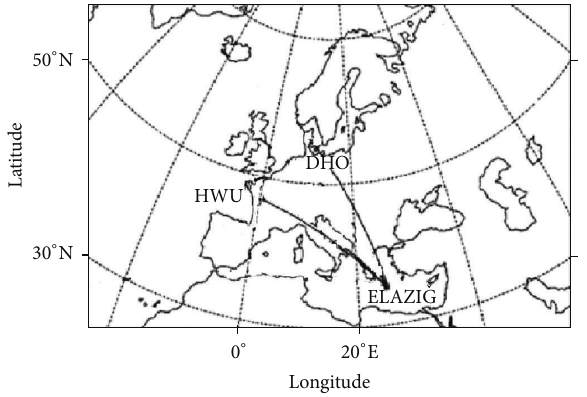
Figure 1: The GCPs connecting the Elazig receiver with the VLF